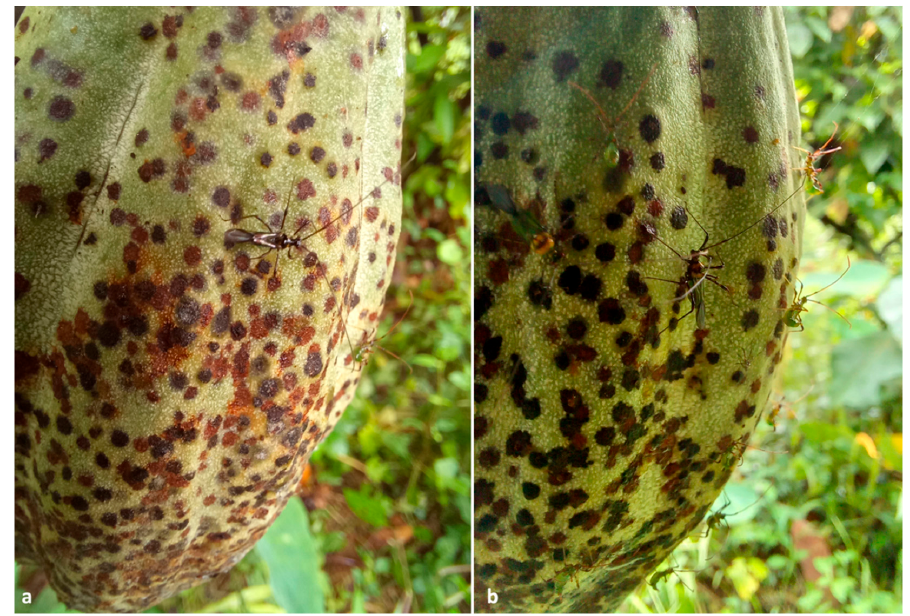
Figure 4. ( a , b ) Close views of cocoa pods attacked by Helopeltis theivora . The brownish circular spots are fruit necroses induced by the bug piercing with their mouthparts. In both images, H. theivora adults and nymphs can be observed while feeding upon the pod.